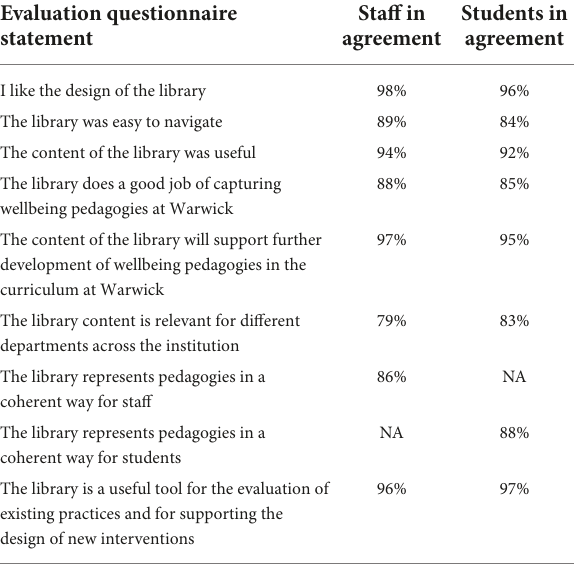
TABLE 6 Anonymous feedback from University of Warwick Digital Repository